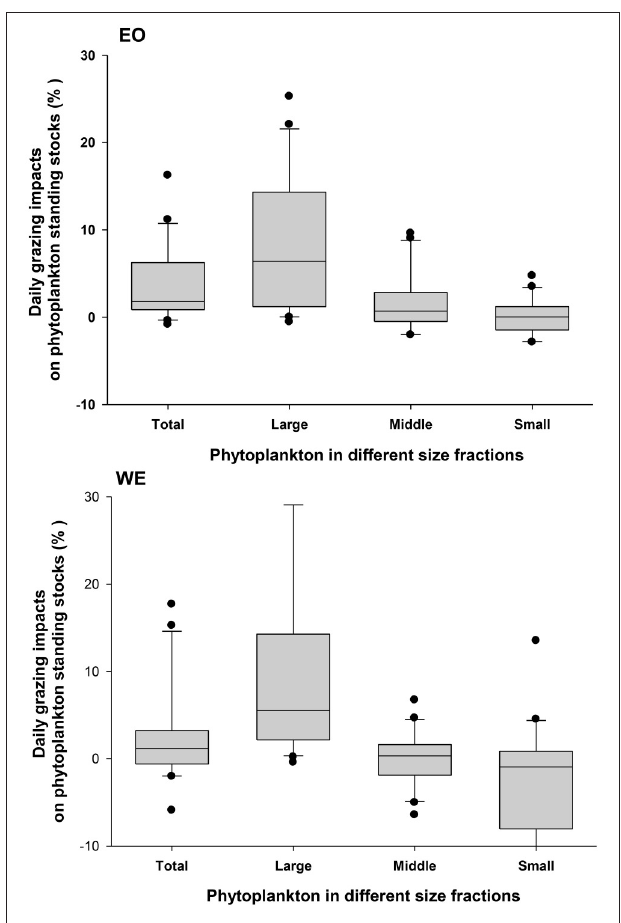
FIGURE 11 | Mesozooplankton grazing impacts on total phytoplankton community (Total) and phytoplankton with different sizes (Large: > 20 µ m; Middle: 2 ∼ 20 µ m and 5 ∼ 20 µ m in the first and the second sampling year, respectively; Small: < 2 and < 5 µ m in the first and the second sampling year, respectively) at the two stations EO and WE. Data are expressed as median (horizontal bar) with 25th–75th (box) and 10th–90th (whiskers)